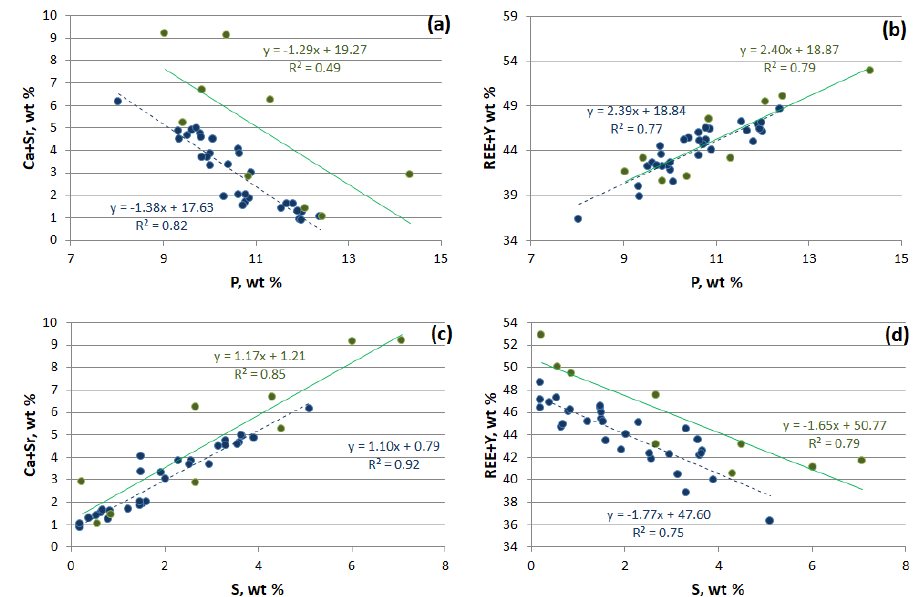
Figure 5. Correlation between main elements of rhabdophane. Green, Tescan Vega 3 SEM analyses; blue, Hitachi S-3400N SEM analysis.